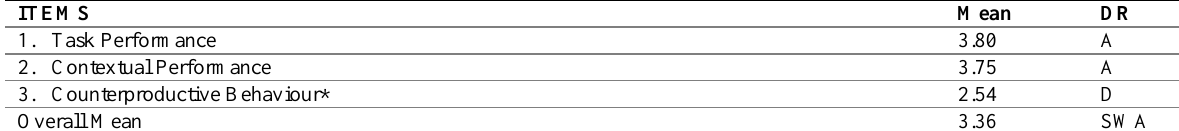
Table 10: Summary Table of Individual Work Performance